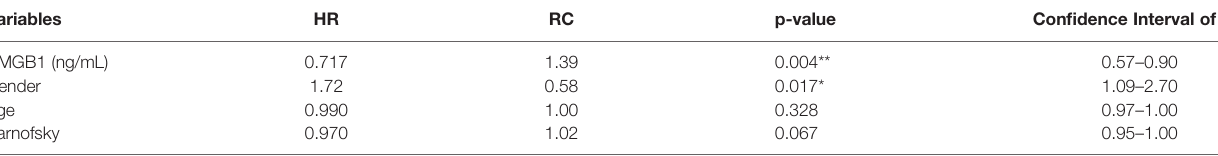
TABLE 6 | Extended Cox model